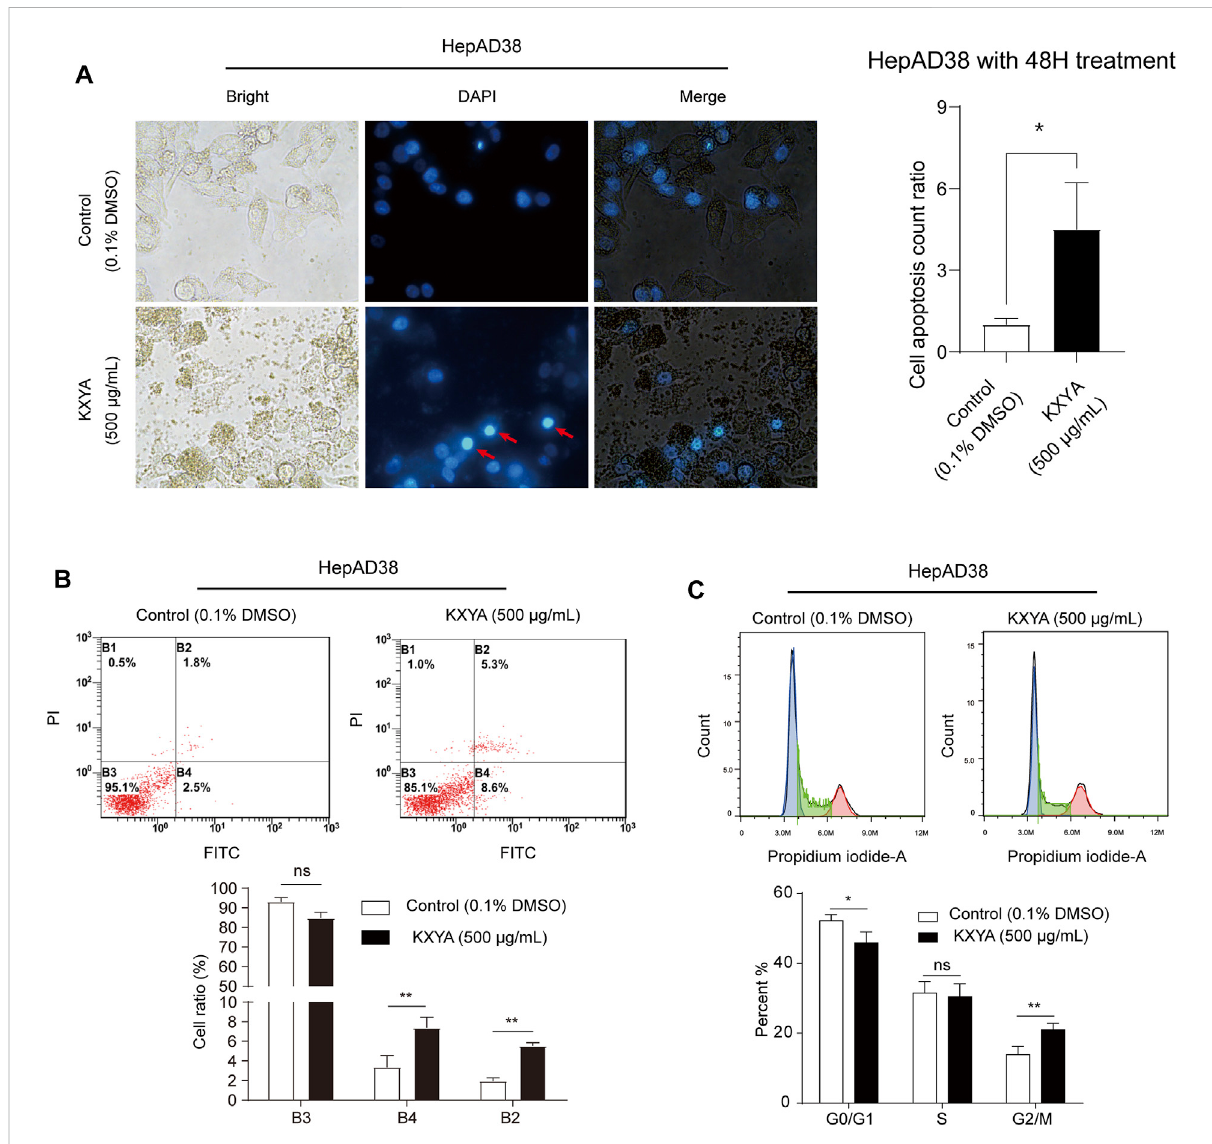
FIGURE 3 KXYA promoted apoptosis of HepAD38 cells. (A) HepAD38 cells was treated with KXYA (500 μ g/ml) for 48 h, the representative images were DAPI fl uorescence, bright and merge images, and statistical analysis of cell apoptosis count ratio. (B) HepAD38 cells was treated with KXYA (500 μ g/ ml) for 48 h, then performed PI/Annexin V-FITC fl uorescent staining and fl ow cytometry. (C) HepAD38 cells was treated with KXYA (500 μ g/ml) for 48 h, then performed PI fl uorescent staining and fl ow cytometry. Data are presented as the mean ± SD, p -value was calculated by